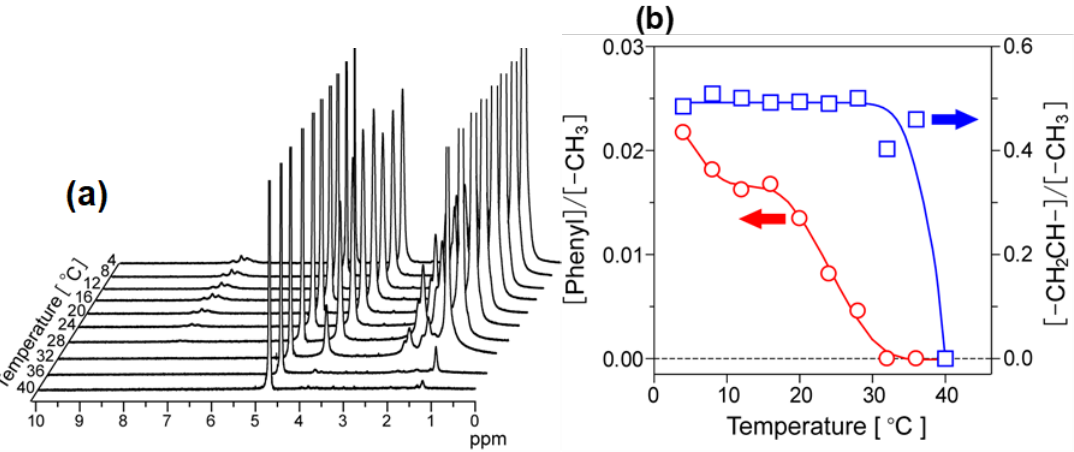
Figure 5. Temperature-variable 1 H-NMR spectra of poly(NIPAAm- block -NIPAAm- co -PBA) in D 2 O from 4 to 40 ◦ C ( a ) and the relative 1 H-peak area intensities of the phenyl groups of boronic-acid moieties (open circle) and – CH 2 CH – polymer main chains (open square) against isopropyl – CH 3 ( b ). The influence of phase transition on the chemical environment and structures of boronic-acid groups of the diblock copolymers was investigated by using temperature-variable 11 B-NMR measurements. Figure 6a shows some typical 11 B-NMR spectra of D 2 O solution of poly(NIPAAm- block -NIPAAm- co -PBA) at the temperature of 4 – 40 C (BF 3 ·OEt 2 was used as an external reference).